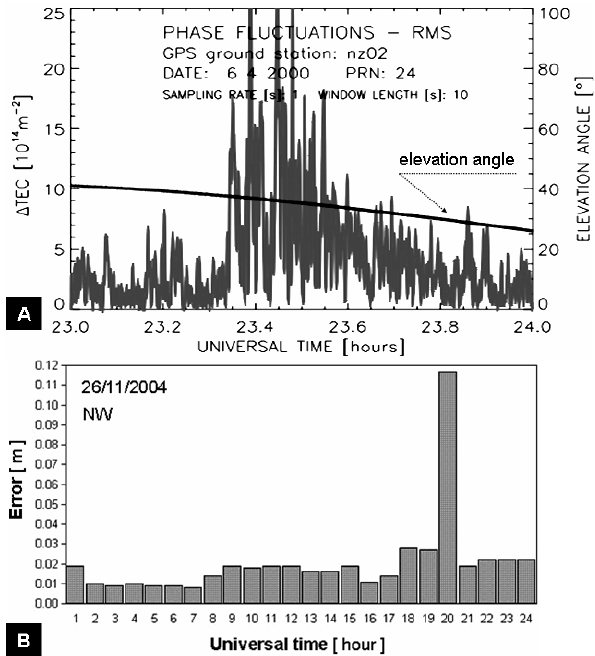
Fig. 2. A : Phase fluctuations observed during the 6–7 April 2000 storm. B : Network Model Integrity monitoring. Increased errors observed from 19:00 UT to 20:00 UT on 26 November 2004 in the northwest German reference